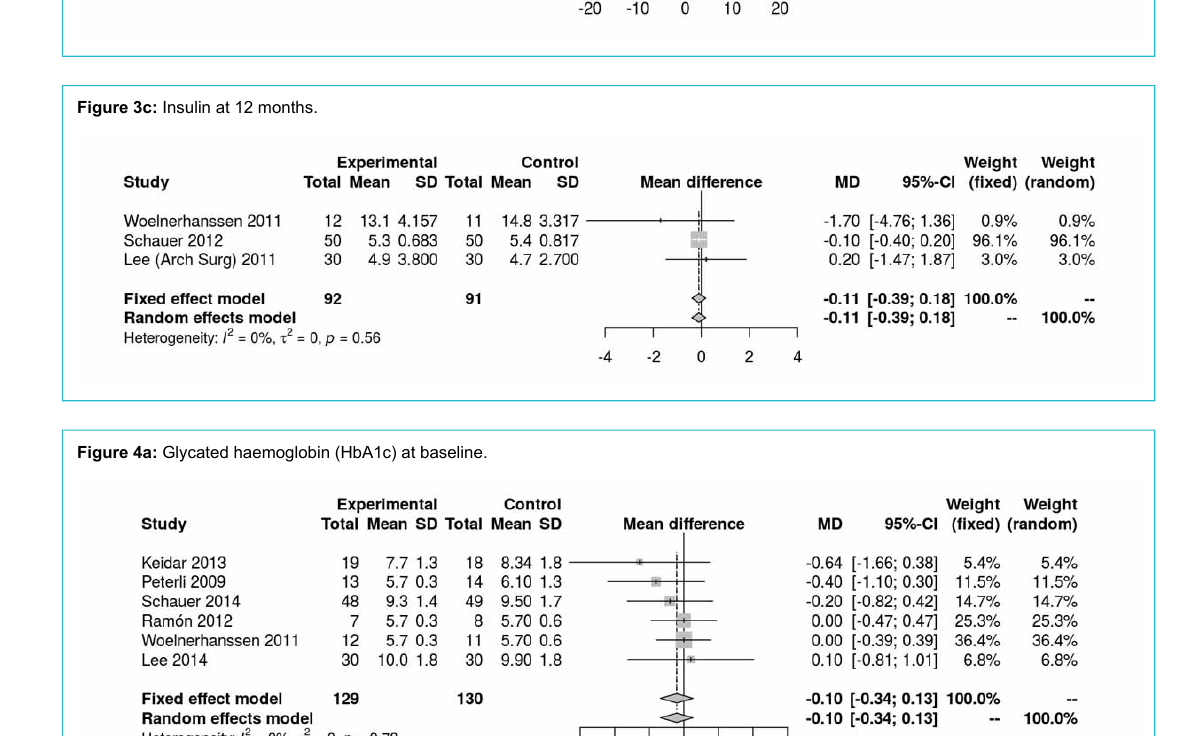
Figure 3c: Insulin at 12 months.